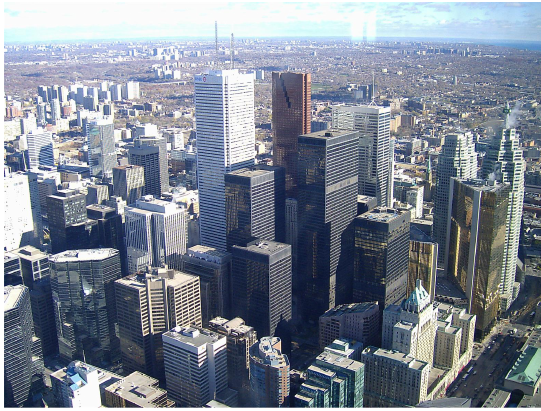
Figure 1: A complex urban scene, downtown